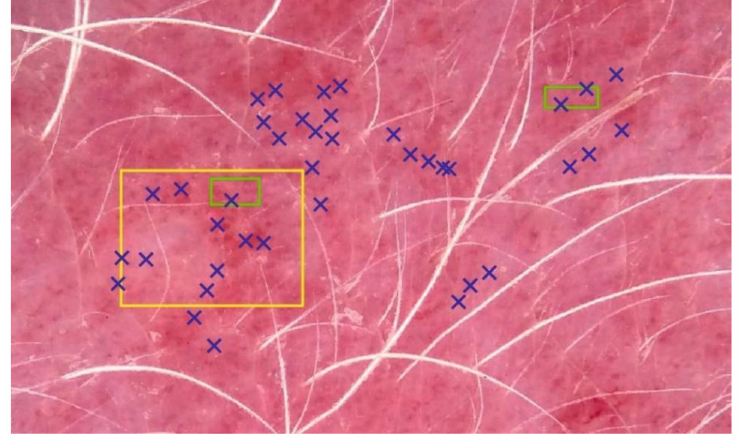
Figure 4. Three image-sampling methods (ISMs). Erythema index (EI) calculation was based on 60 pixels (PT, blue), and all the pixels in two small (SQ2, green) or one big square (SQ1, yellow). For the sake of simplicity, only a few selected pixels are shown for the PT